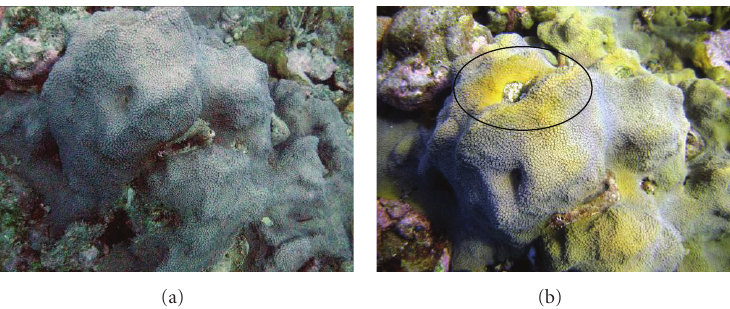
Figure 2: Photographic time series of a colony at Enrique showing signs of YBD. (a) January 2009; (b) September 2009.